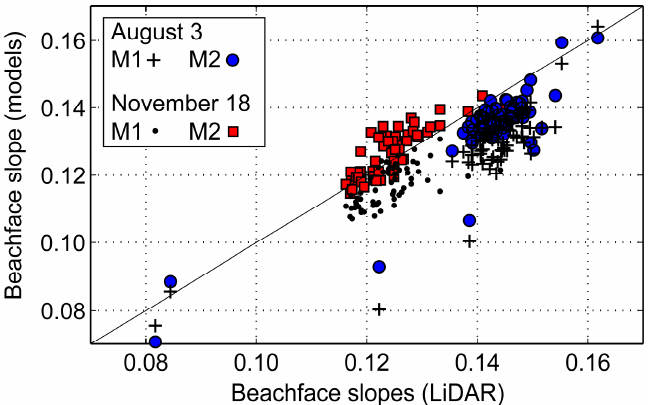
Figure 13. Longshore variability in beachface slopes between video-based models and LiDAR-based DEMs. The black line is the 1:1 line.